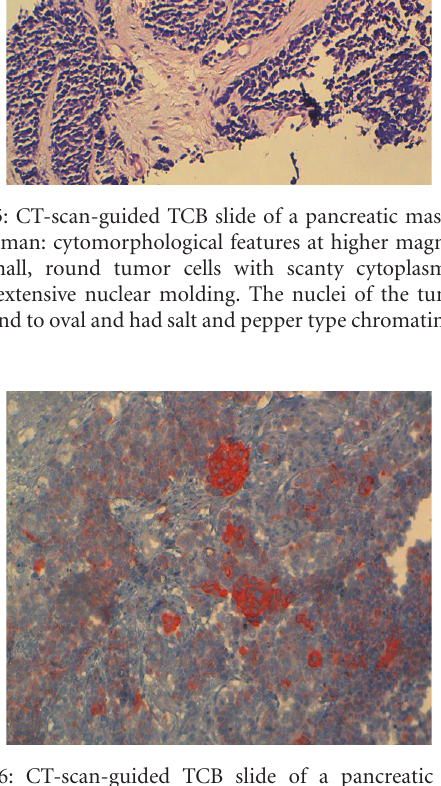
Figure 6: CT-scan-guided TCB slide of a pancreatic mass in a 56 year-old man. Immunohistochemical features at higher magnification view: positive reaction for cytokeratin 7 in tumor